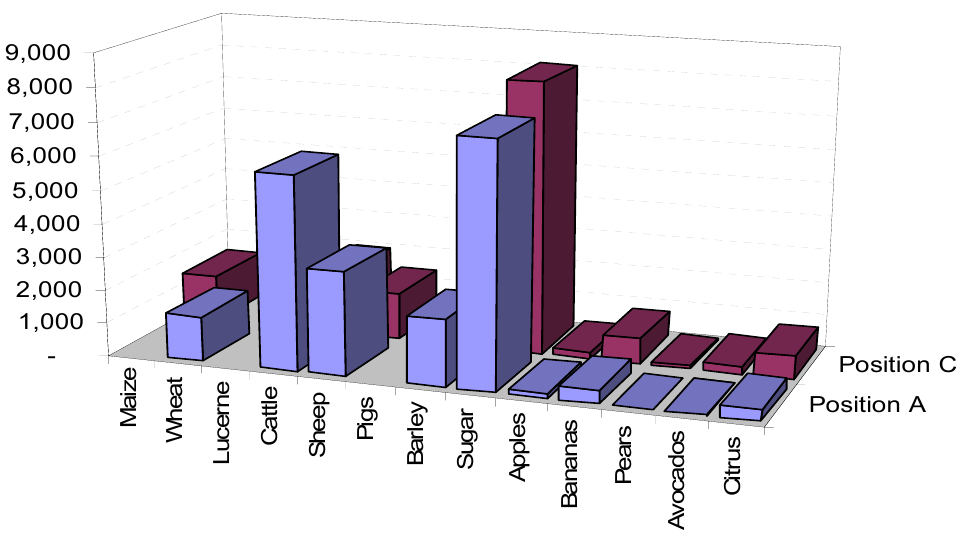
Figure 8 - Land allocations for current portfolio and the minimum risk portfolio